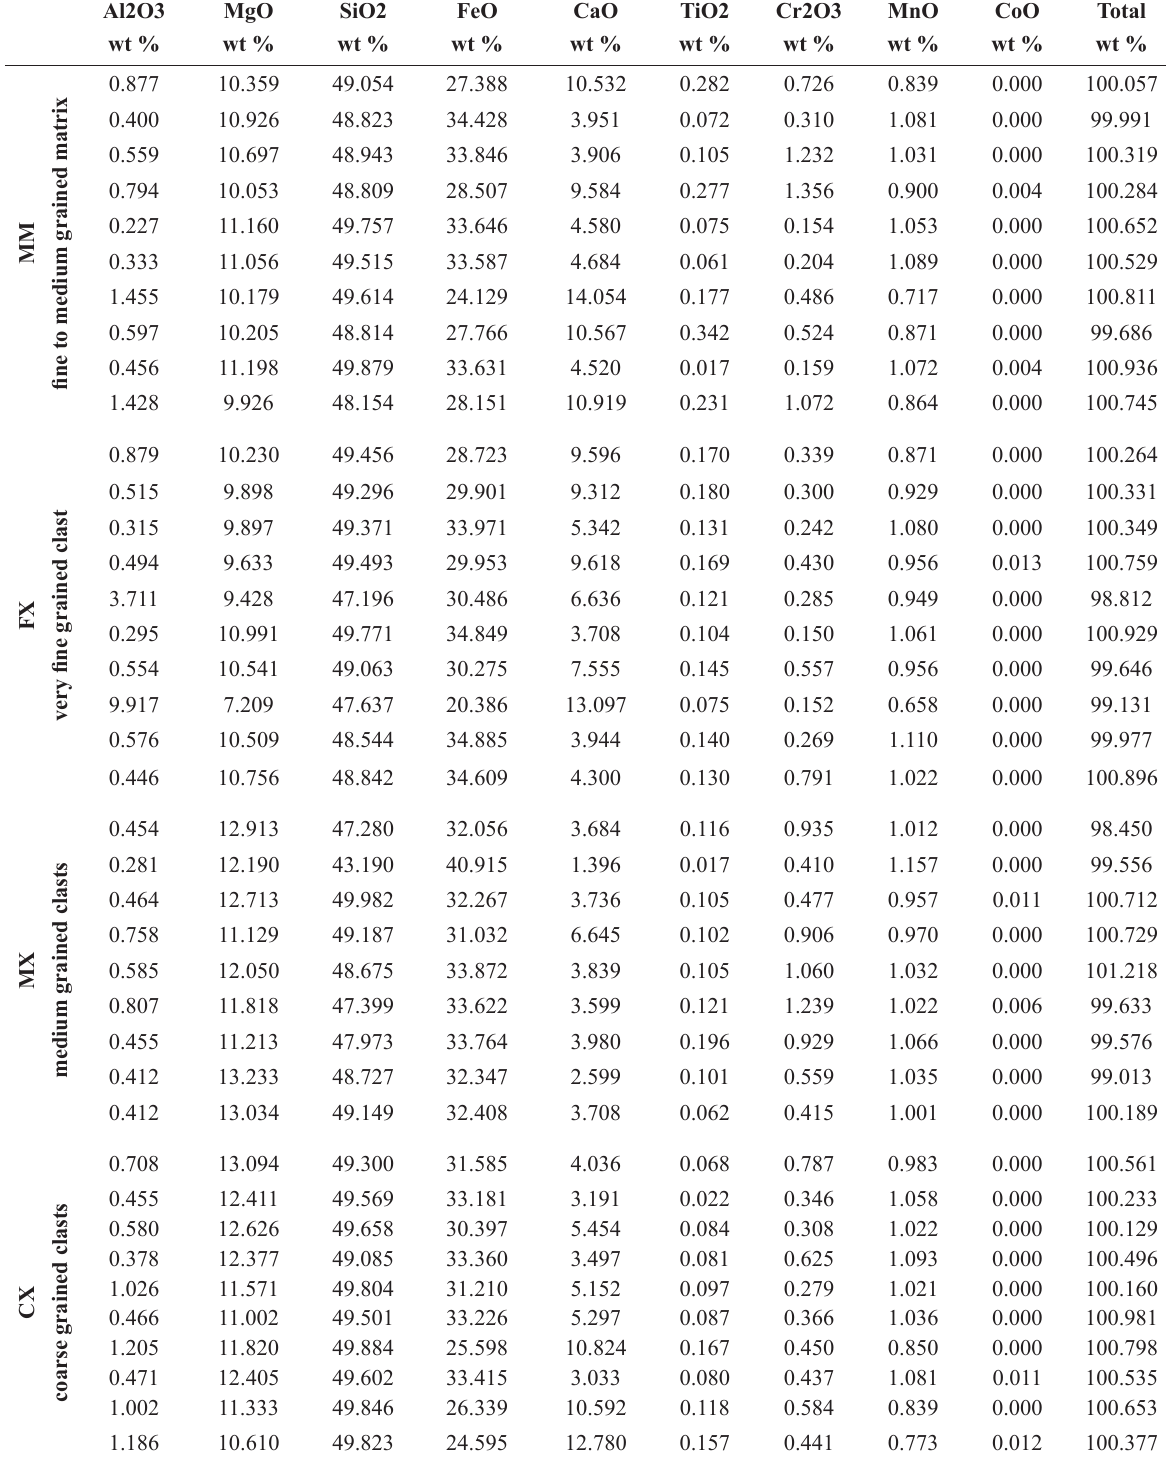
Major and trace element composition of pyroxenes from the different lithologies present in Serra Pelada meteorite. Quantitative WDS analysis in wt.